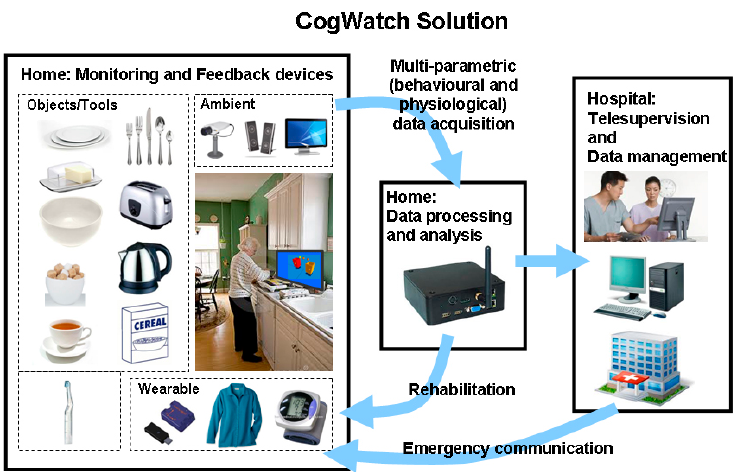
Figure 1. Schematic of the CogWatch concept.